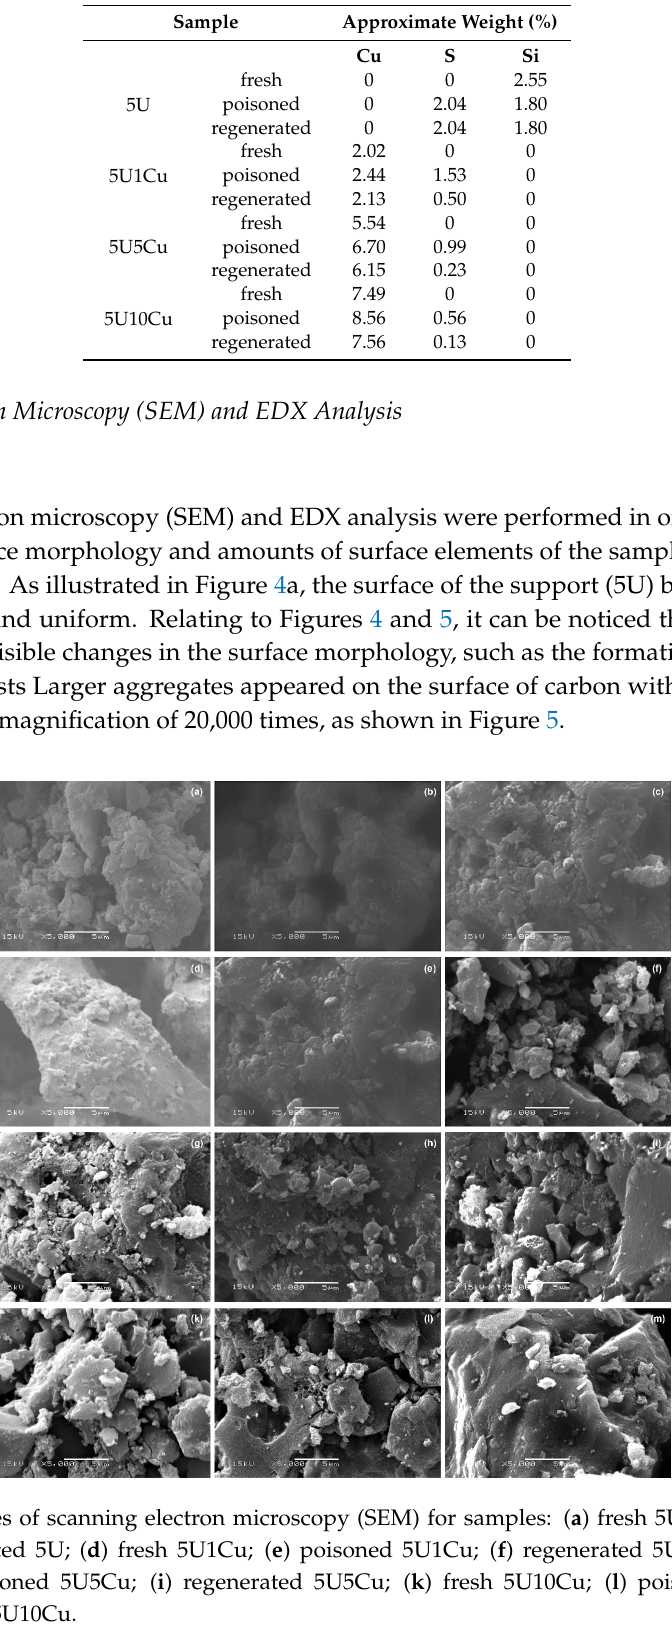
Table 4. Results of energy-dispersive X-ray spectroscopy (EDX) elemental analysis of the fresh, poisoned, and regenerated catalysts.